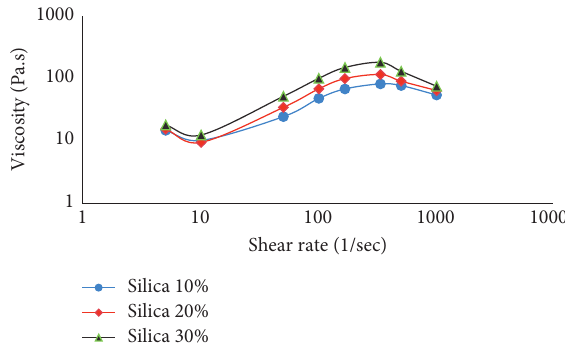
Figure 6: Viscosity curves of STFs containing PEG 400g/mole at varying nanosilica concentrations